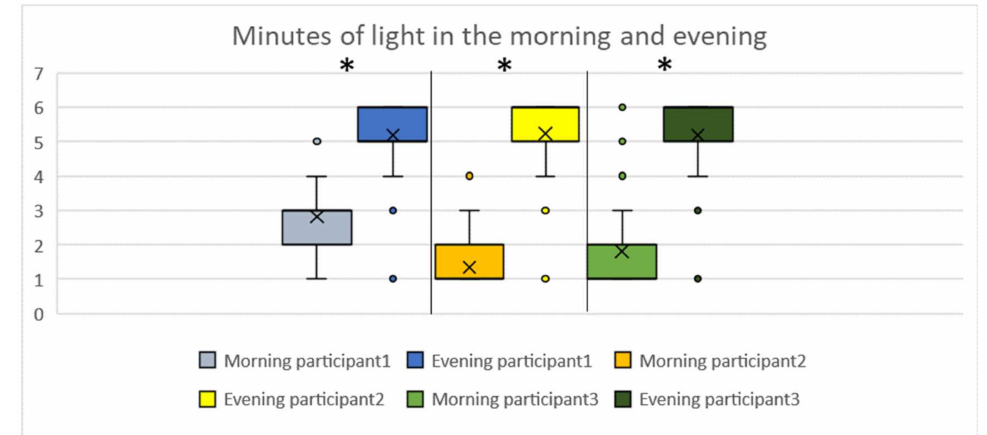
Figure 6. Boxplot of minutes of light received in the morning and evening per participant. The median is demonstrated as the ‘X’ within the boxplot. The length of the boxplot represents the interquartile range, and the boxplot whiskers are 1.5 times the interquartile range. All data points outside the whiskers are considered outliers. (Cluster 1 represents 0–30 min light per day; cluster 2 represents 30–60 min light per day; 3 represents 60–90 min light per day; cluster 4 represents 90–120 min light per day; cluster 5 = 120–150 min light per day; cluster 6 ≥ 150 min light per day). * = Wilcoxon Signed ranks test significant difference between morning and evening ( p <